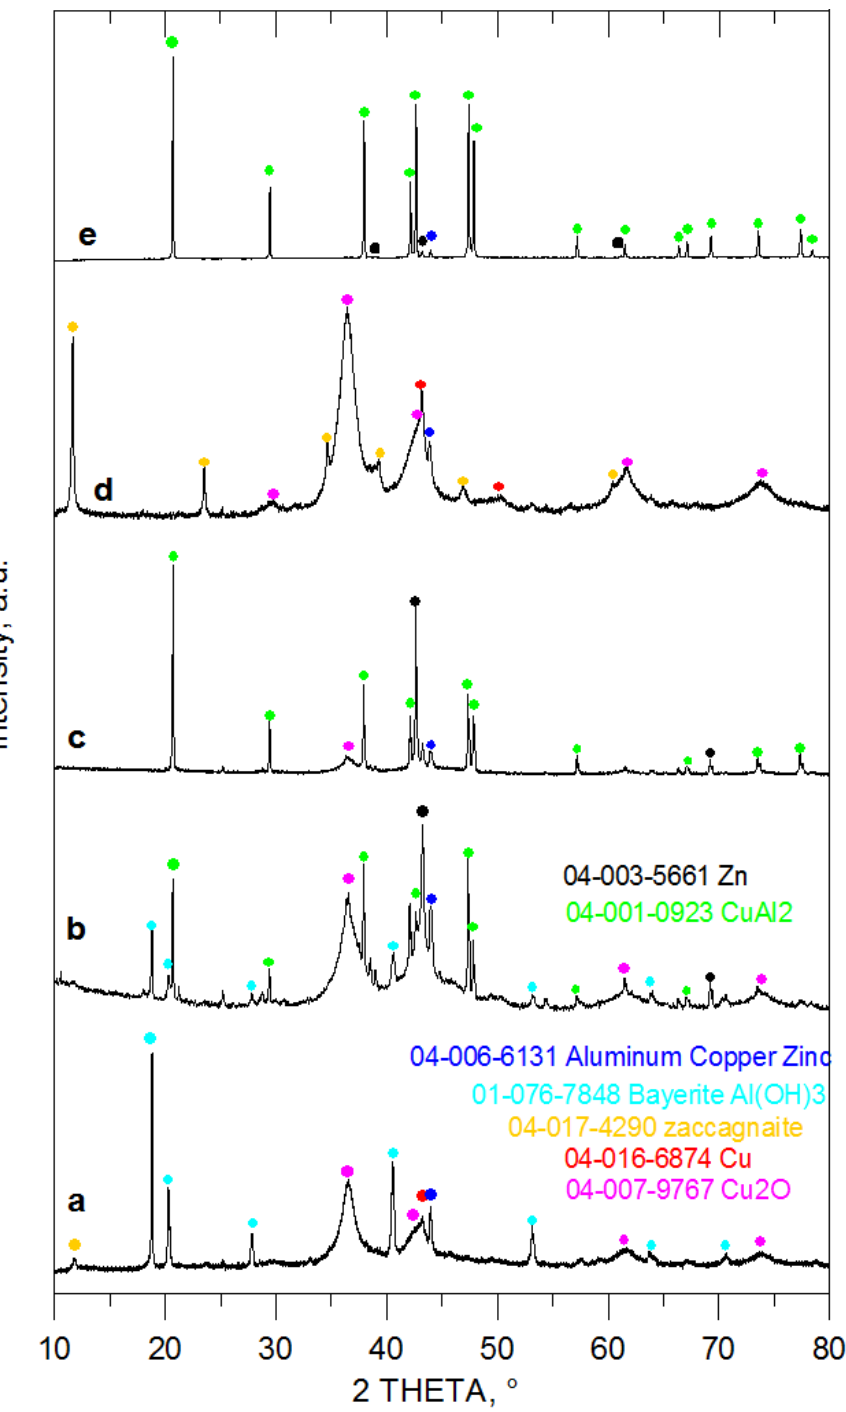
Figure 3. Powder X-ray diffractograms of undissolved residues obtained from different amounts of Dev. alloy used for the HDB of 5 mM BRX dissolved in 100 mM aqueous NaOH after 16 h of action (100% conversion to 4-HBN in all cases): ( a ) 0.5 g/100 mL; ( b ) 0.6 g/100 mL; ( c ) 0.3 g/100 mL (+0.8 g of NaBH 4 ); ( d ) 2.7 g of Dev. alloy after 180 min. action 5 mM BRX in 100 mM aqueous. NaOH (900 mL) and after subsequent 16 h of action of 5 mM BRX in 100 mM aqueous NaOH (100 mL). ( e ) starting Dev. alloy (predominantly contains CuAl 2 ).